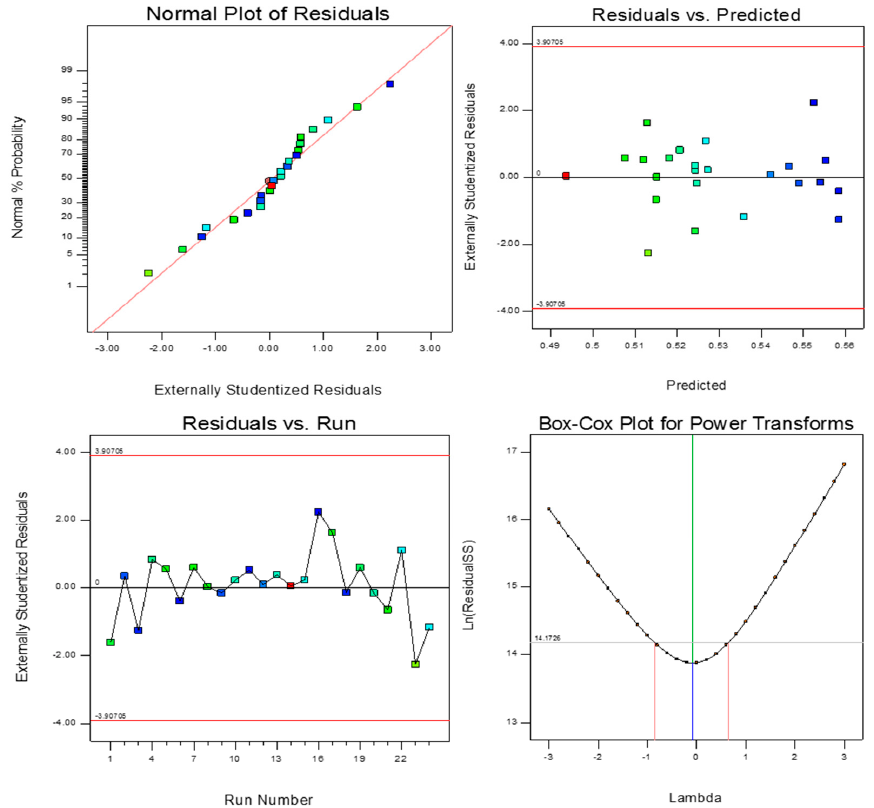
Figure 14. Post ANOVA verification tools for the prediction of maximum peak load. Figure 15 represents the counter of prediction value for responses of DOE analysis